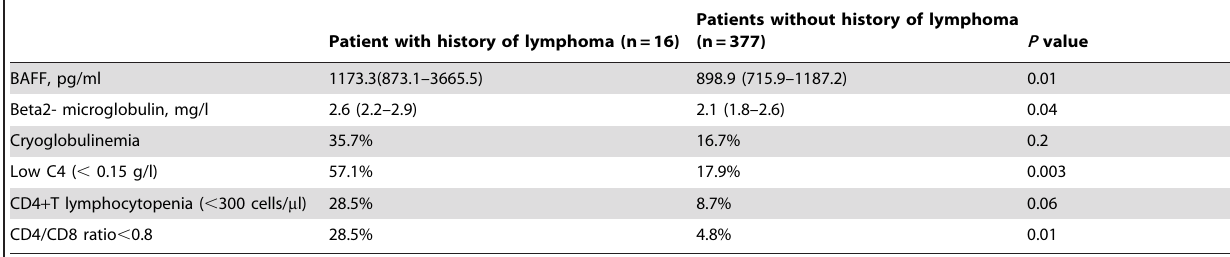
Table 4. Characteristics associated with a history of